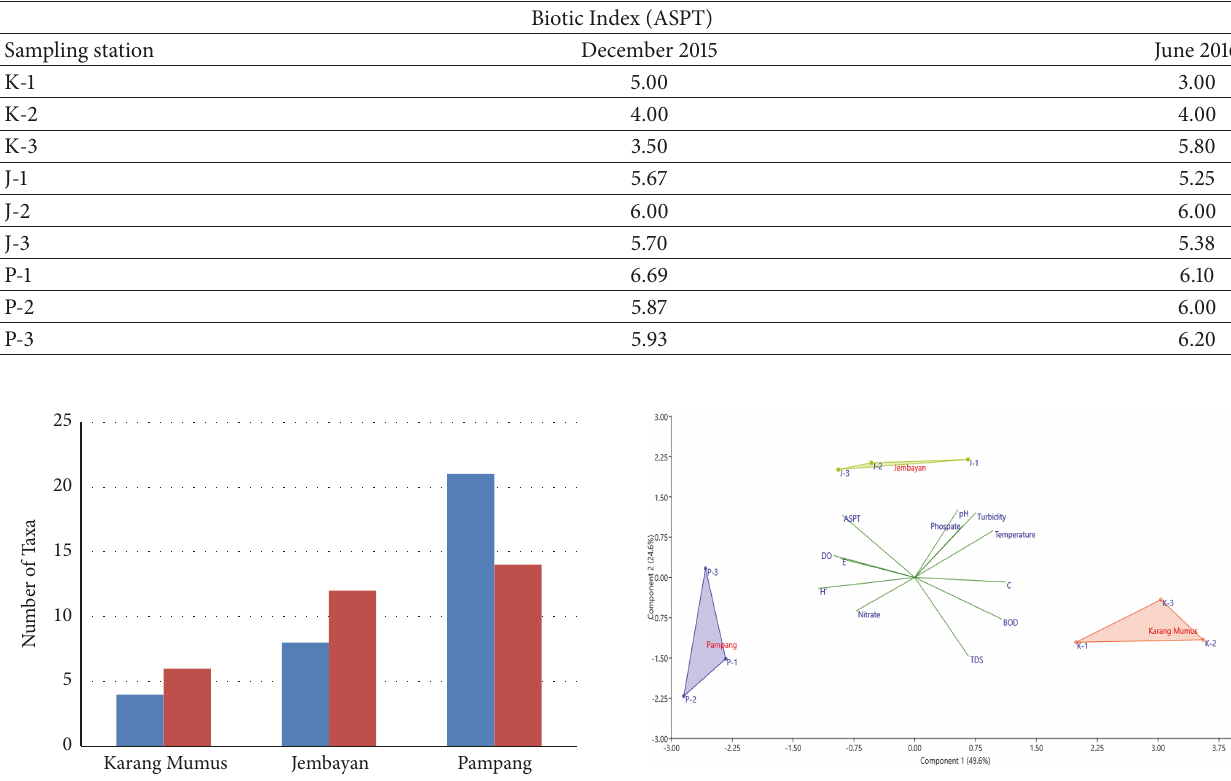
Figure 5: Diagram of sampling sites by Principal Component Analysis(PCA),basedonthebioticmeasuresandphysical-chemical variables in East Kalimantan of Indonesia in December 2015.